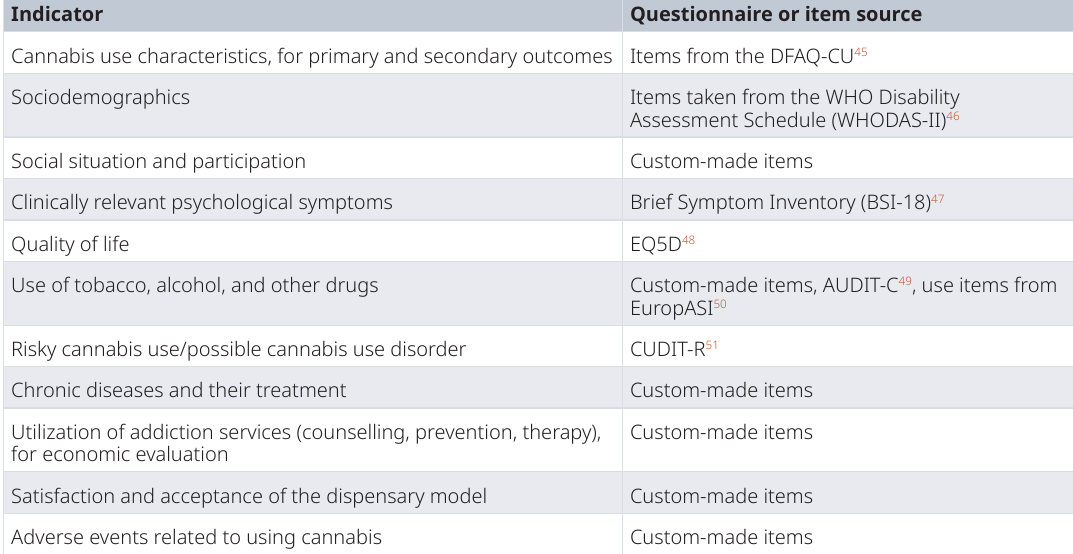
Table 2. Summary of questionnaire assessment.